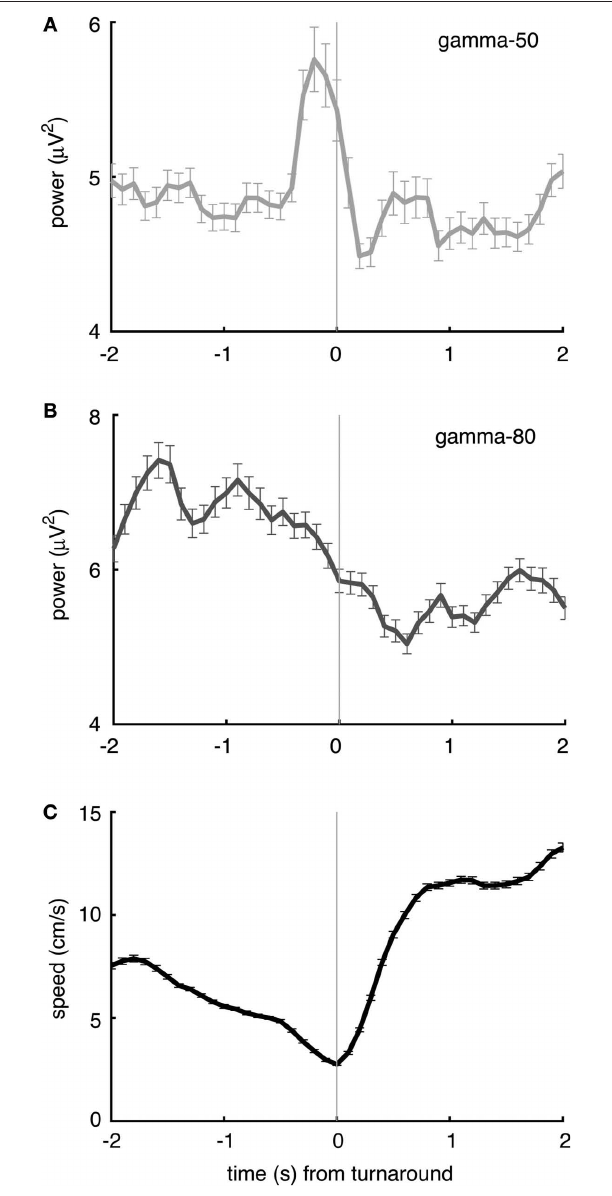
FIGURE 11 | Putative fast-spiking interneuron (FSI) spike-triggered averages (STAs) indicate interactions with local fi eld potentials. (A,B) Example STA of two FSIs. The STA of the top neuron shows clear gamma modulation; note also the asymmetric slow component following a spike. The bottom neuron shows 12 Hz, but not gamma, modulation. In general, different FSIs exhibited a range of different STA patterns, and a signifi cant proportion were not modulated. (C) Average STA across all FSIs; note gamma oscillation and asymmetric slow defl ection. The sharp spike at time 0 likely resulted from the spike waveform interfering with the LFP, a consequence of recording both from the same tetrode.